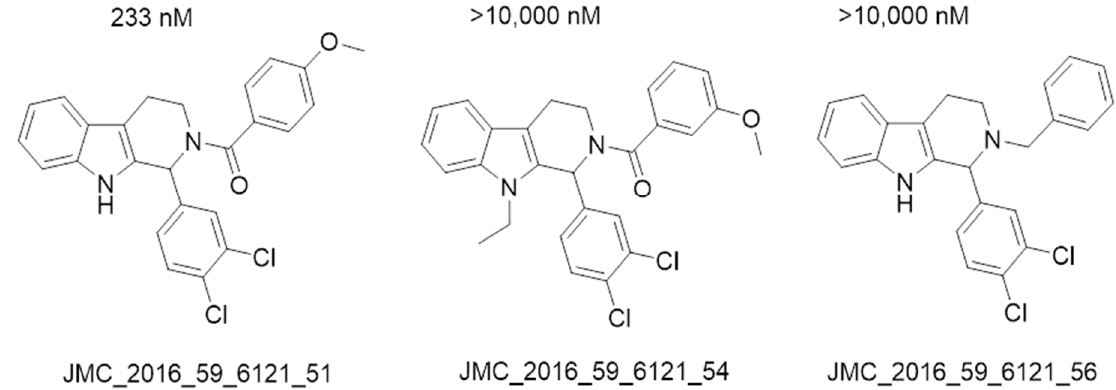
Figure 12. Structure and biological activity of tetrahydroxy- β -carbolin derivatives. In the Chalcon derivatives, the hydrogen bonds (donor or acceptor) of Asn 391 and Gln 393 with 2 methoxy groups on ring A played a vital role. The hydrophobic groups of ring B interacted with the hydrophobic amino acids (Leu 539, Ala 397, Val 536). This was consistent with the bioactive test. The molecule JMC_2013_67_115_17 belongs to the group of Flavone and benzoflavone derivatives, the oxygen atoms of the C ring acted as a hydrogen bond acceptor with Glu 393. The hydrophobic groups such as prenyl, methoxyl on the A ring of the chromone could have good activity by interacting with the hydrophobic amino acids of the binding site such as Leu539, Ala397, and Val536. In addition, the hydrogen bond acceptor of the ring B (such as the methoxyl group) could be a way to increase the interaction. The docking score of Quinazoline derivatives group was quite low, showing good interaction with the binding site. In the structure BMC_2013_21_7858_20 (Figure 13), quinazoline had 2 nitrogen atoms as hydrogen bond acceptors with Gln181, Asn391, and Gln 393; the secondary amine of quinazoline with phenyl group may donate hydrogen to have hydrogen bond with Glu 446 and Gln 393. The nitrite group, which was involved in the hydrogen bond acceptor with Glu446, can be replaced by the hydrogen bond donor or acceptor. The phenyl group was required to create hydrophobic interactions with amino acids such as Phe181. The result was better when added to the methoxy group.